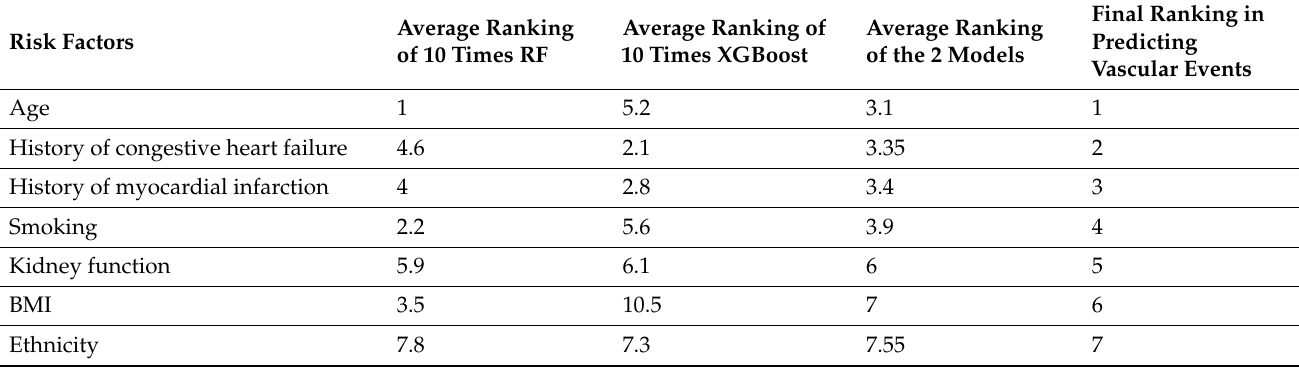
Table 5. Importance ranking of risk factors in predicting vascular events based on RF and XGBoost.